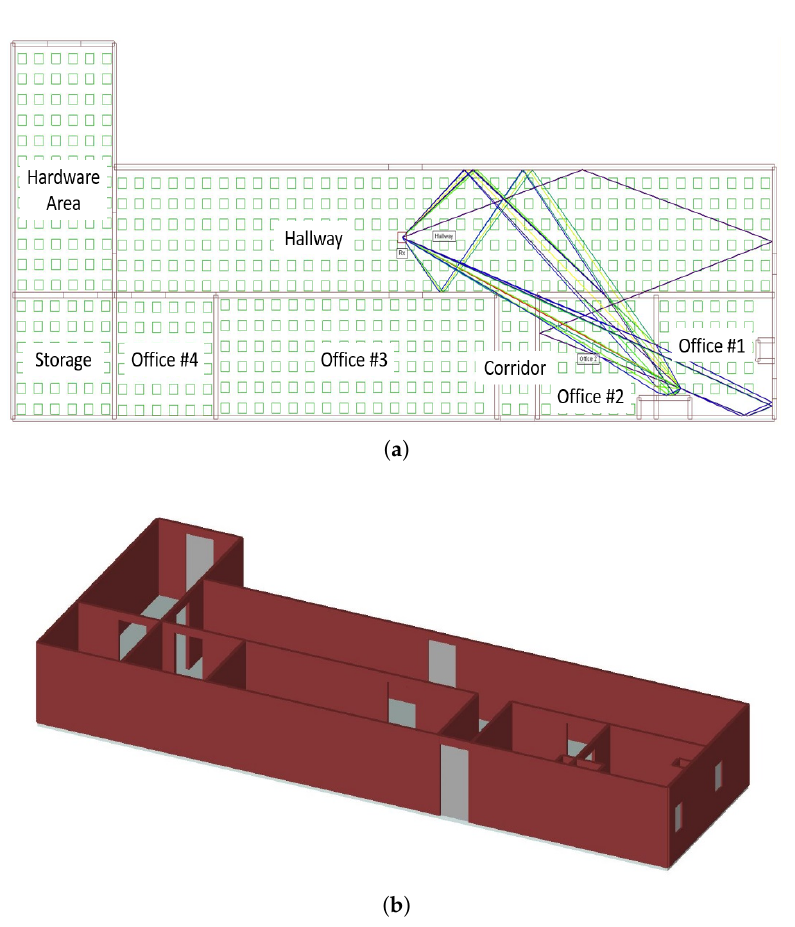
Figure 2. Simulated indoor environment and demonstration of different signal paths emitted from a non-cooperative Universal for Mobile Telecommunications System (UMTS) emitter in Office #1. ( a ) Plan View, ( b ) Perspective